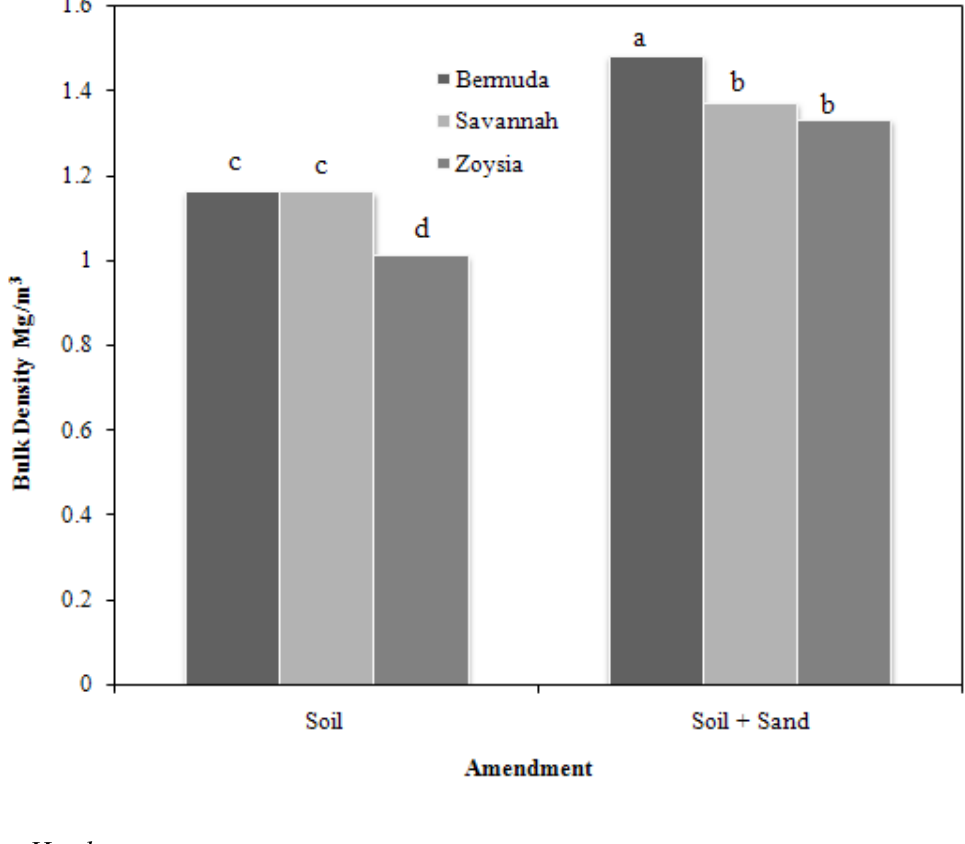
Figure 1. Sand layering effect on root zone bulk density for three